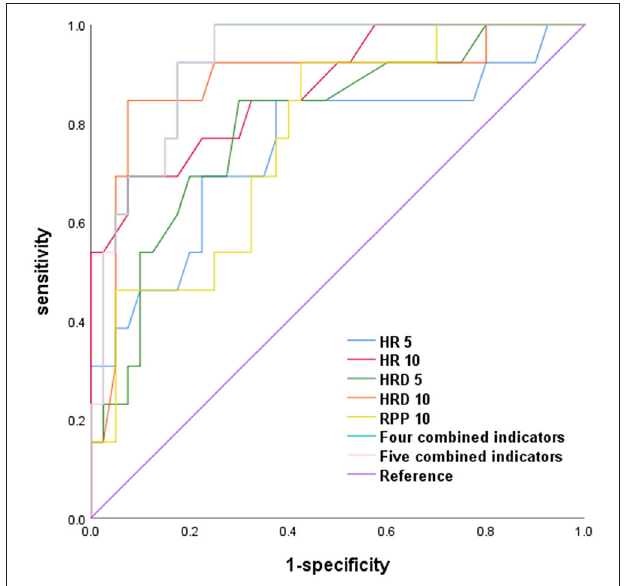
FIGURE 1 | ROC comparison of HR, HRD, RPP, and combined indicators to predict the POTS